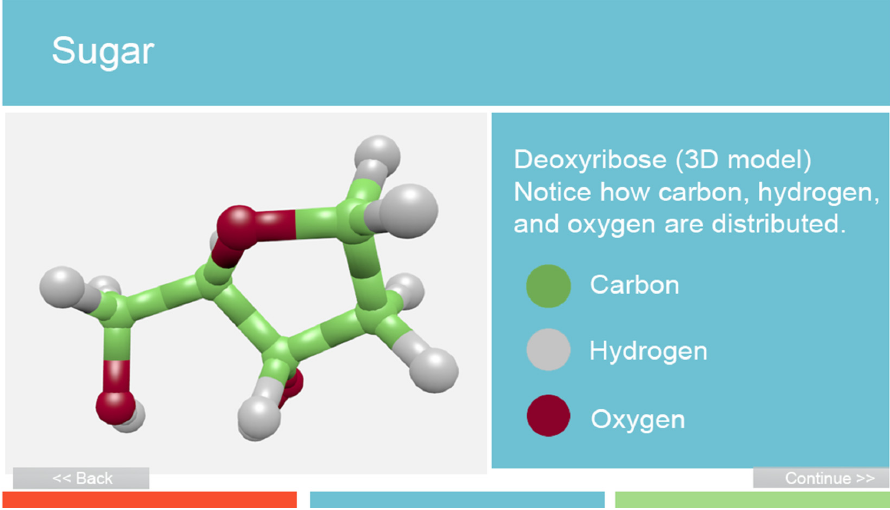
Figure 2. Examples of content for desktop screening: 3D representation of